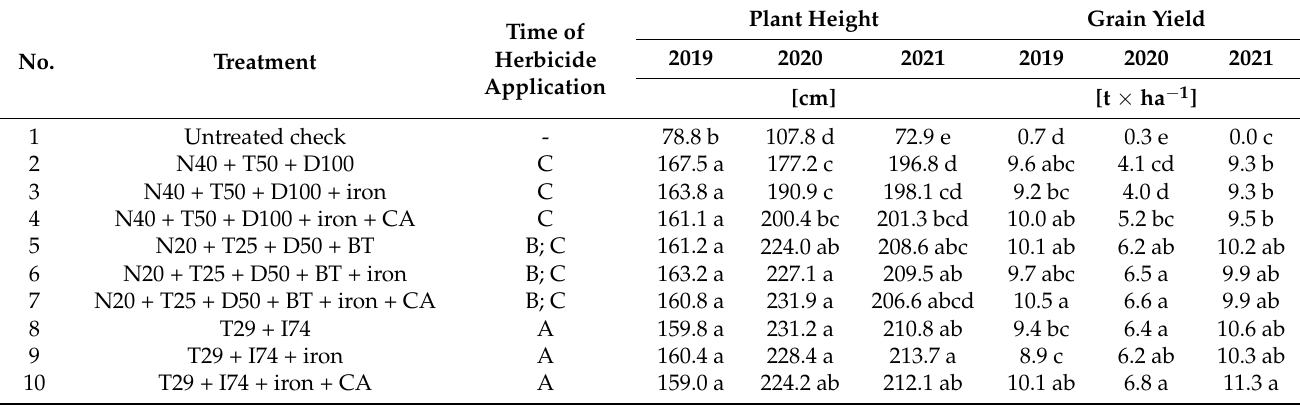
Table 7. Impact of dose and time application on maize height and grain yield.